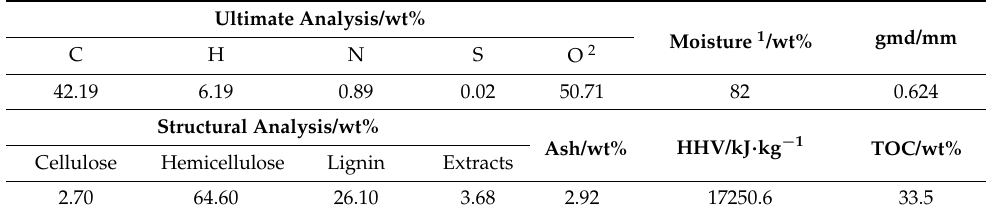
Table 1. Guava fruit waste characterization.